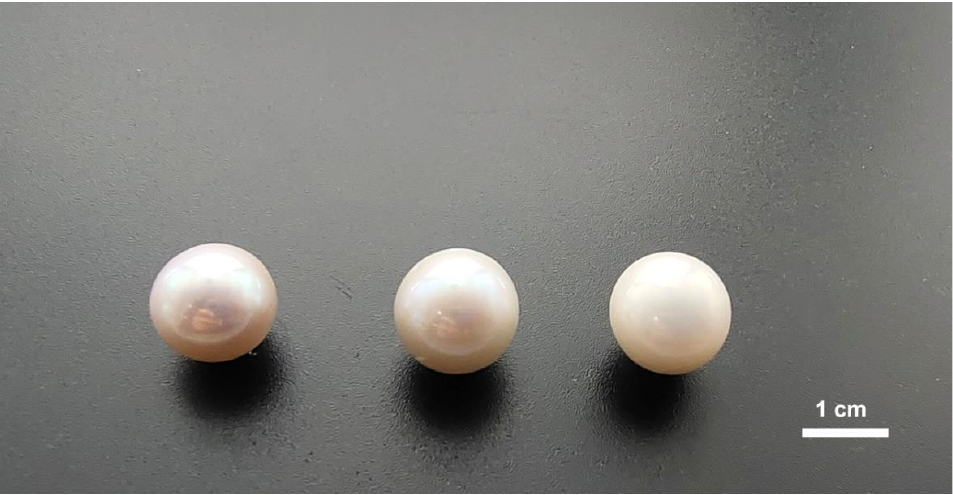
Figure 1. Chinese large freshwater nucleated pearl samples with different quality